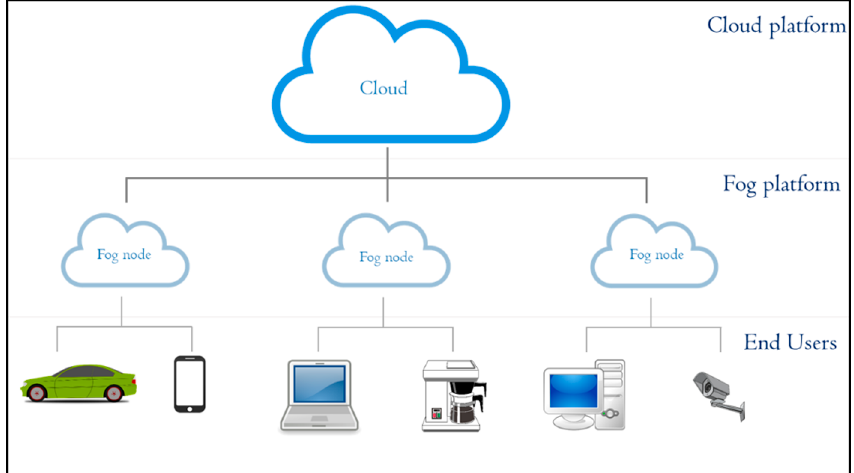
Figure 1 . Overview of fog computing architecture. Figure 1. Overview of fog computing